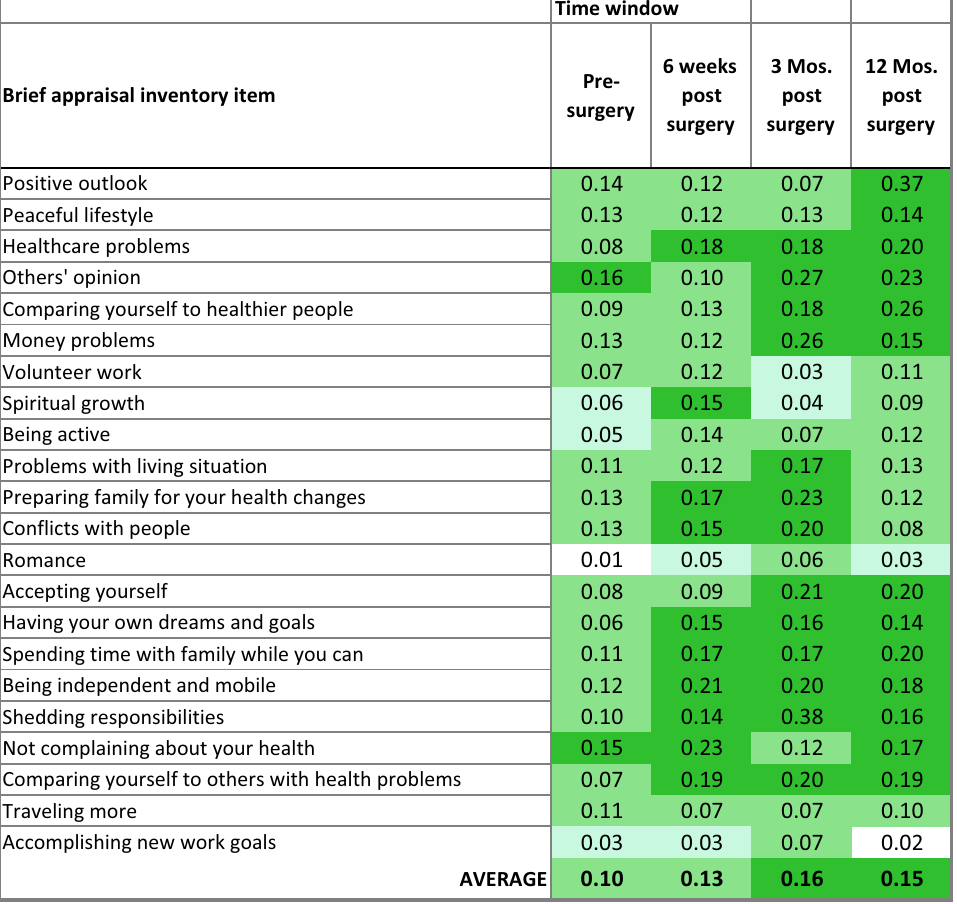
Table 3 MCS: Eta 2 in one-way ANOVA Brief appraisal inventory item